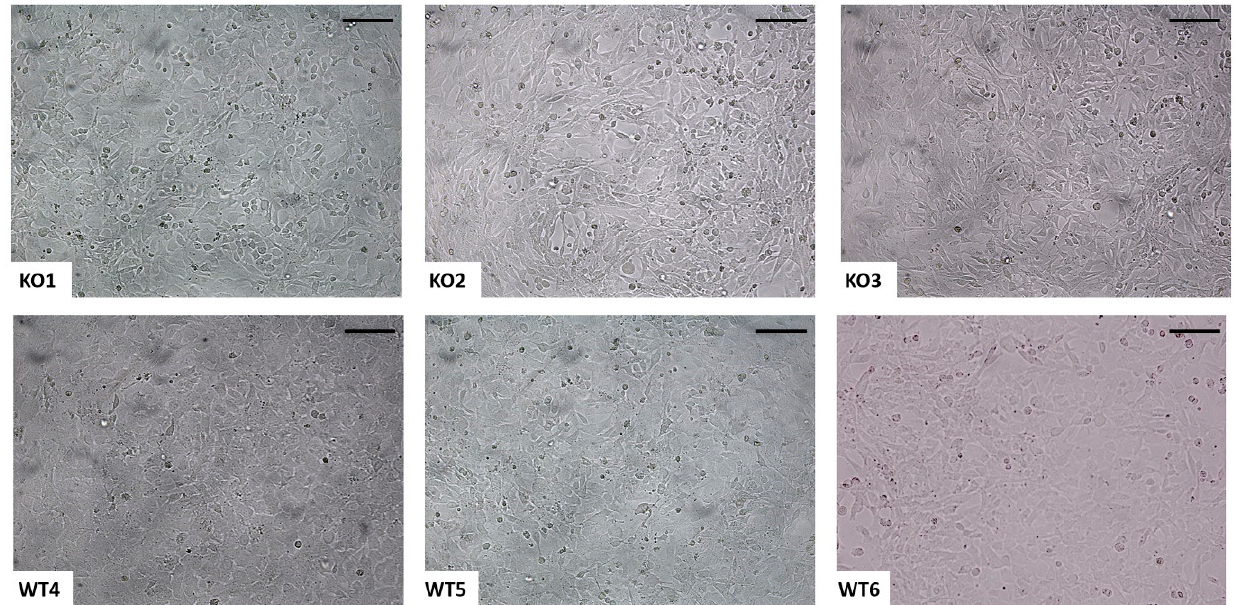
Figure 1. Morphology of immortalized chondrocytes. Representative images of immortalized cell lines at early confluence. Both Cant1 knock-out (KO1, KO2, and KO3) and wild-type (WT4, WT5, and WT6) cells maintained the typical polygonal chondrocyte morphology after immortalization. Scale bar 100 µm.